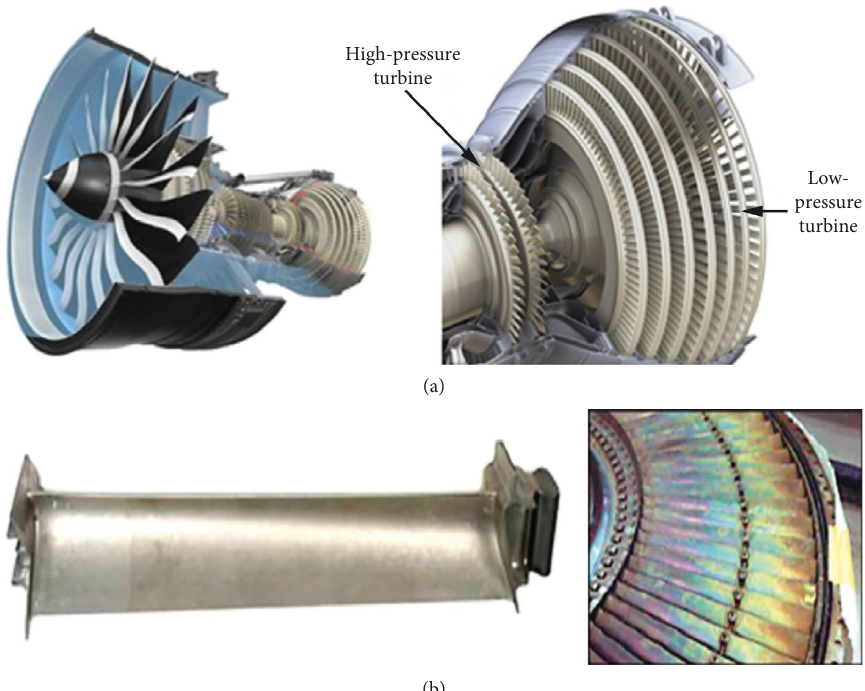
Figure 1: (a) Diagrams showing the complete engine and the turbine section of the GEnx-1B aircraft engine as used on the Boeing 787. (b) Photograph of TiAl LPT blade as used in the last stage of GEnx engine and an assembly of TiAl LPT blades after an engine test as used in the GE CF6 test engine